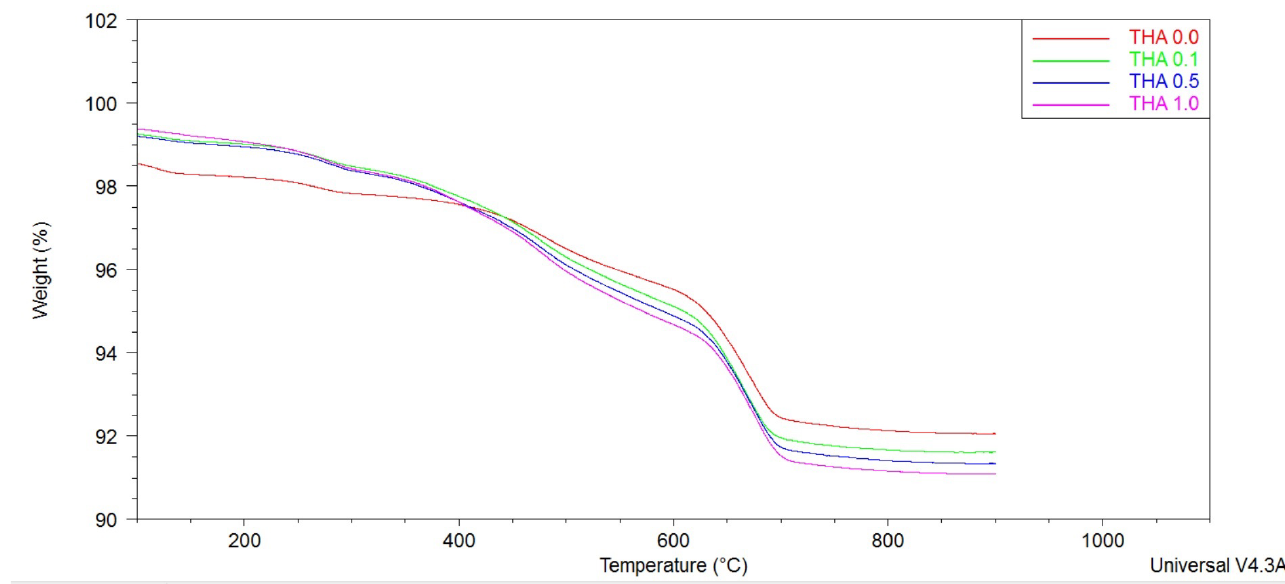
Figure 2. XRD patterns of illite samples.